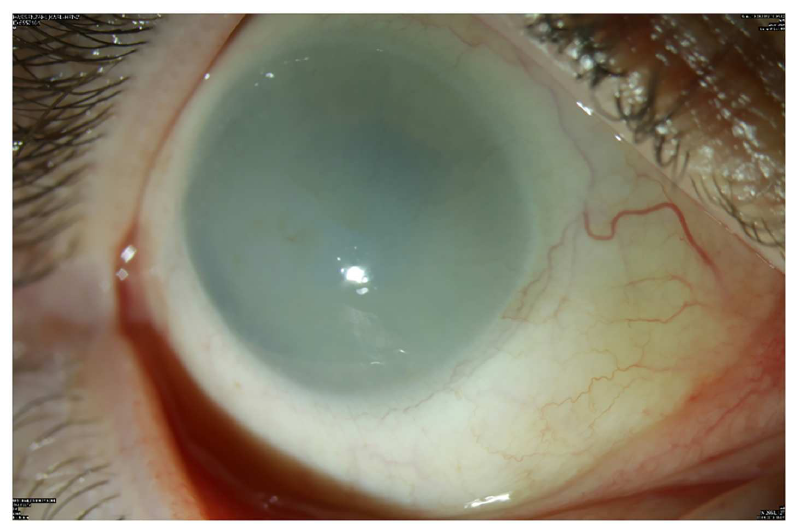
Fig 2. Opaque corneal clouding of grade 4 in patient suffering from MPS I.